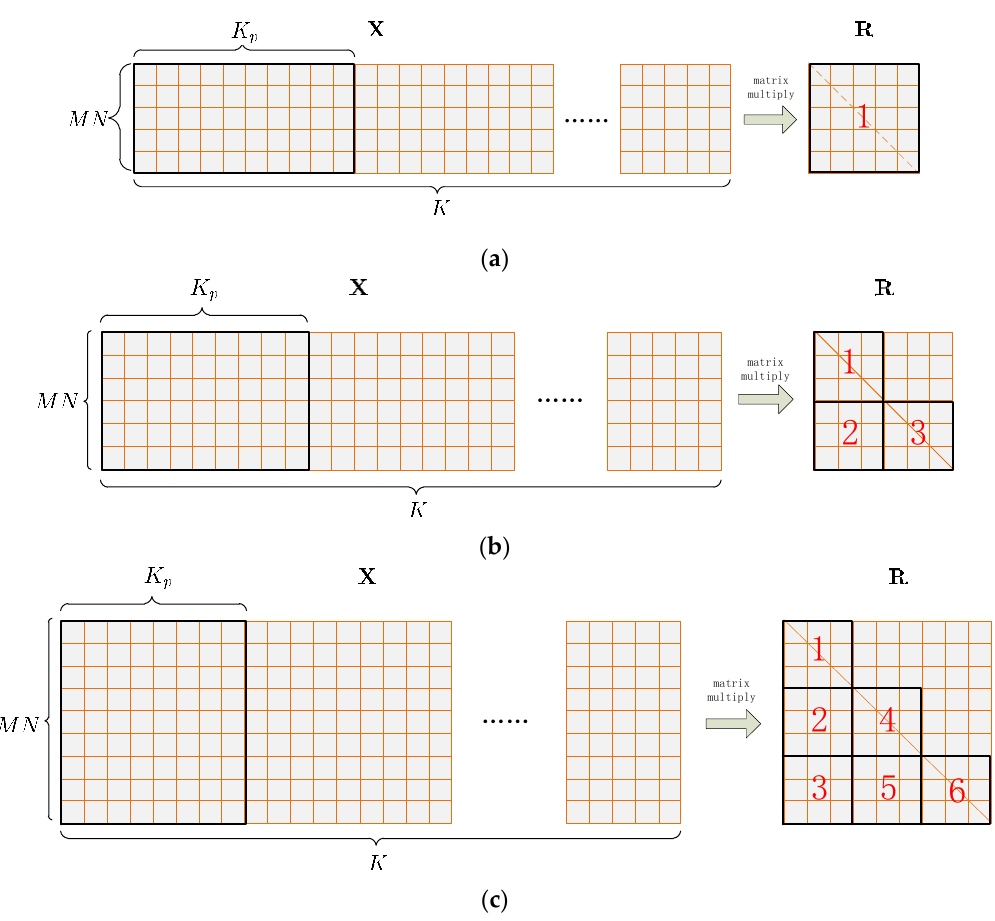
Figure 7. Schematic of the covariance matrix estimation. ( a ) Covariance matrix estimation of size smaller than 30 × 30; ( b ) Covariance matrix estimation of size from 30 × 30 to 59 × 59; ( c ) Covariance matrix estimation of size from 60 × 60 to 80 × 80.